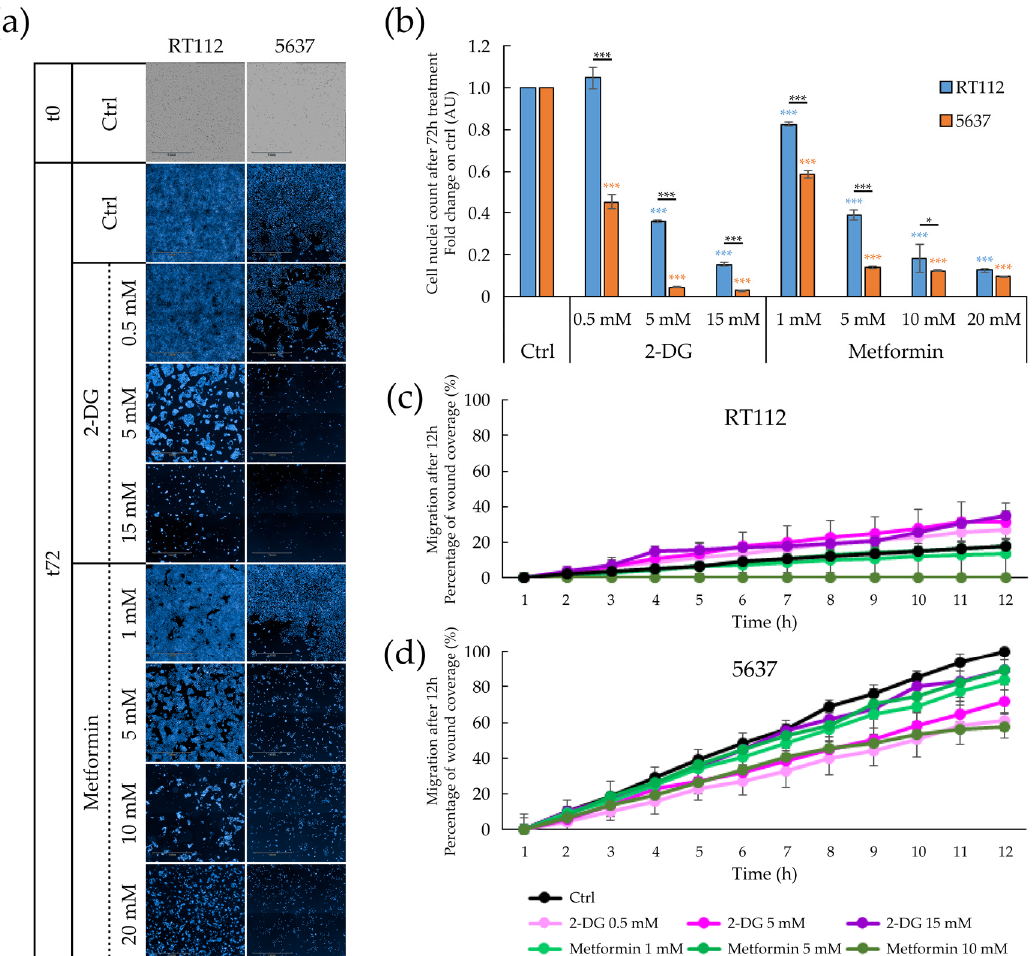
Figure 7. Effect of pharmacological treatment on proliferation and migratory capacity of RT112 and 5637 cells grown as adherent cells. ( a ) Representative images of brightfield (T0) and Hoechst 33342 stained nuclei acquired with Operetta CLS™ of adherent cells after 72 h-treatment with increasing concentration of 2-Deoxy-D-glucose (2-DG) (0, 0.5, 5, 15 mM) and metformin (0, 1, 5, 10, 20 mM). ( b ) Fold change relative to the control condition of nuclei count of cells treated for 72 h grown with 2-Deoxy-D-glucose (2-DG) and metformin treatment. Results are the mean of three experimental replicates. ( c , d ) Percentage of wound coverage in wound healing assay after 12 h-treatment condition of increasing concentration of 2-Deoxy-D-glucose (2-DG) (0, 0.5, 5, 15 mM) and metformin (0, 1, 5, 10 mM) of RT112 cells ( c ) and 5637 cells Results are the mean of two experimental replicates, except for 15 mM 2-DG and 10 mM metformin conditions performed in single replicate. Statistical test: t -test, * for p < 0.05; *** for p < 0.001.